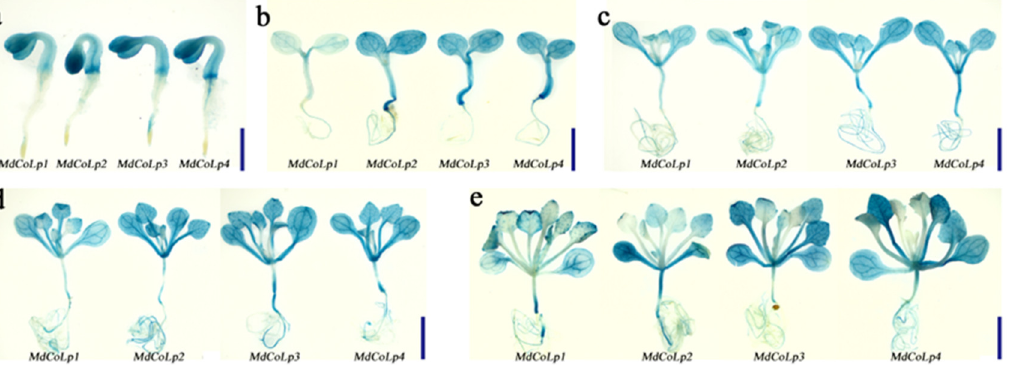
Figure 4. Histochemical staining of GUS in Arabidopsis plants transformed with the MdCoLp1/2/3/4::GUS construct. The age of Arabidopsis seedlings in ( a – e ) were 2 days, 5 days, 12 days, 18 days and 25 days, respectively. The scale bar of ( a – e ) is 2 mm.